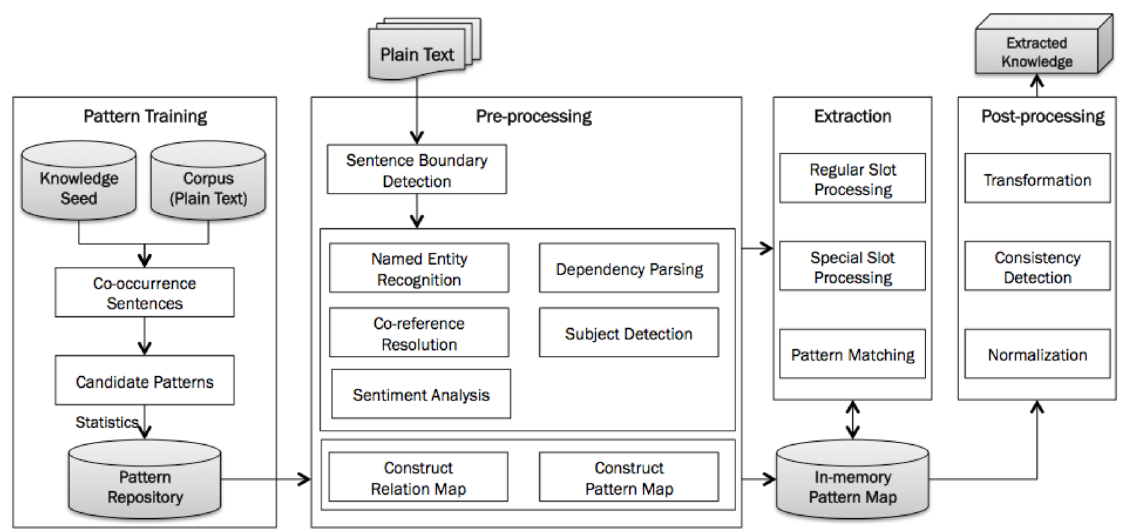
Figure 2 A high-level workflow of unstructured data extraction